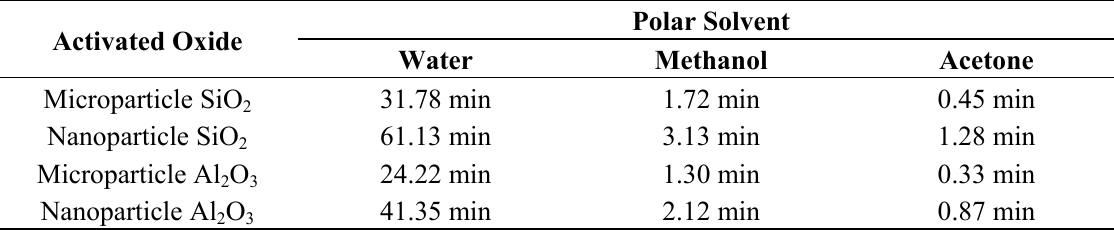
Table 4. Evaporation time of activated fluxes (at an operating temperature of 25